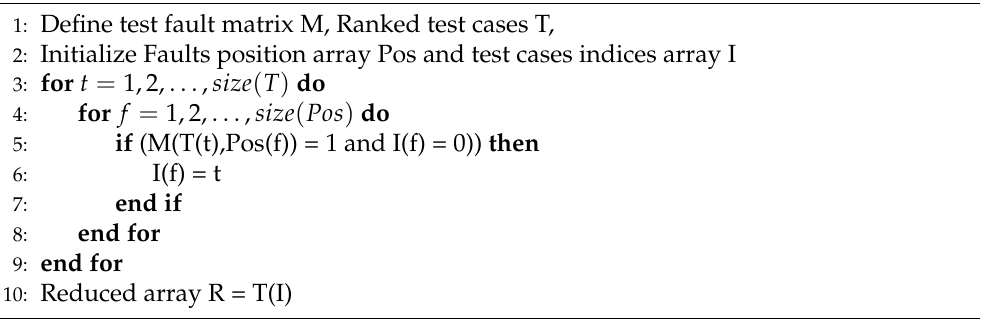
Algorithm 3 IQPSO